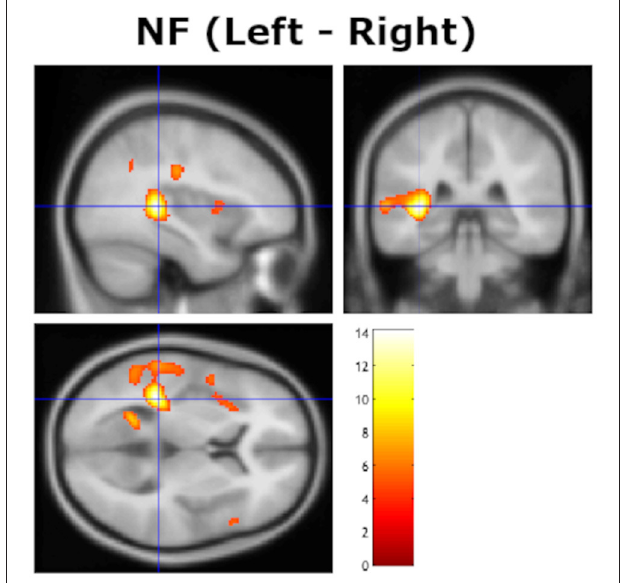
FIGURE 2 | Remaining significant activation in the left hemisphere after contrasting with homologous voxels in the right hemisphere for the non-forced (NF) attention instruction condition, thresholded at p = 0.05 (FWE corrected). The cross-hair is at x , y , z coordinates − 36, − 33, 9. Color bar shows t